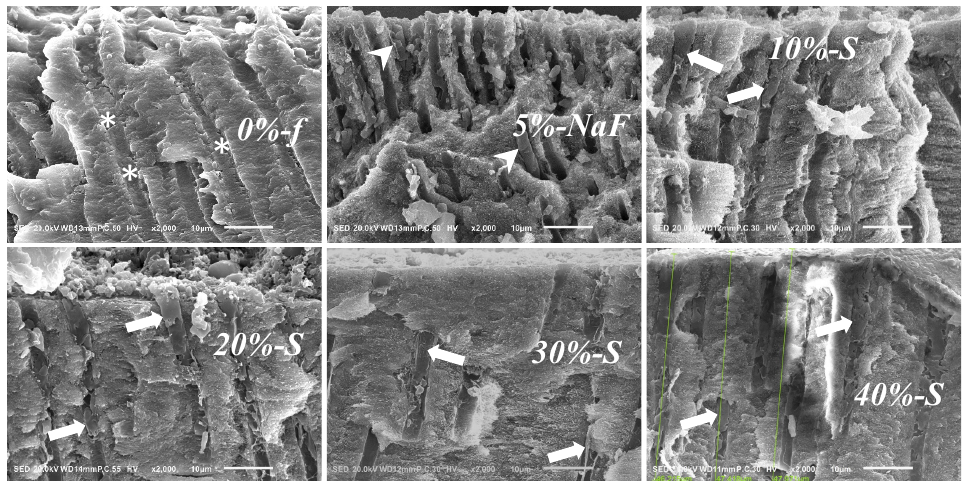
Figure 7. SEM images of longitudinally fractured root dentin after DV applied with pressure; original magnification: 2k. In 0-f% , there appears to be layers of filler-less DV along the walls of the DTs (asterisks). Only a few cylindrical DVs are seen in 5%-NaF (arrowheads). Some solidified cylindrical DV materials remain plugged in the DTs in 10%-S (arrow). Some cylindrical DV materials remained plugged at the root surface that penetrated deep into the DTs in 20%-S (arrow). Similar tags of DV could be seen in 30%-S (arrow). Solidified cylindrical DV materials are seen plugged more than 47 µ m deep into the DTs in 40%-S (arrow).